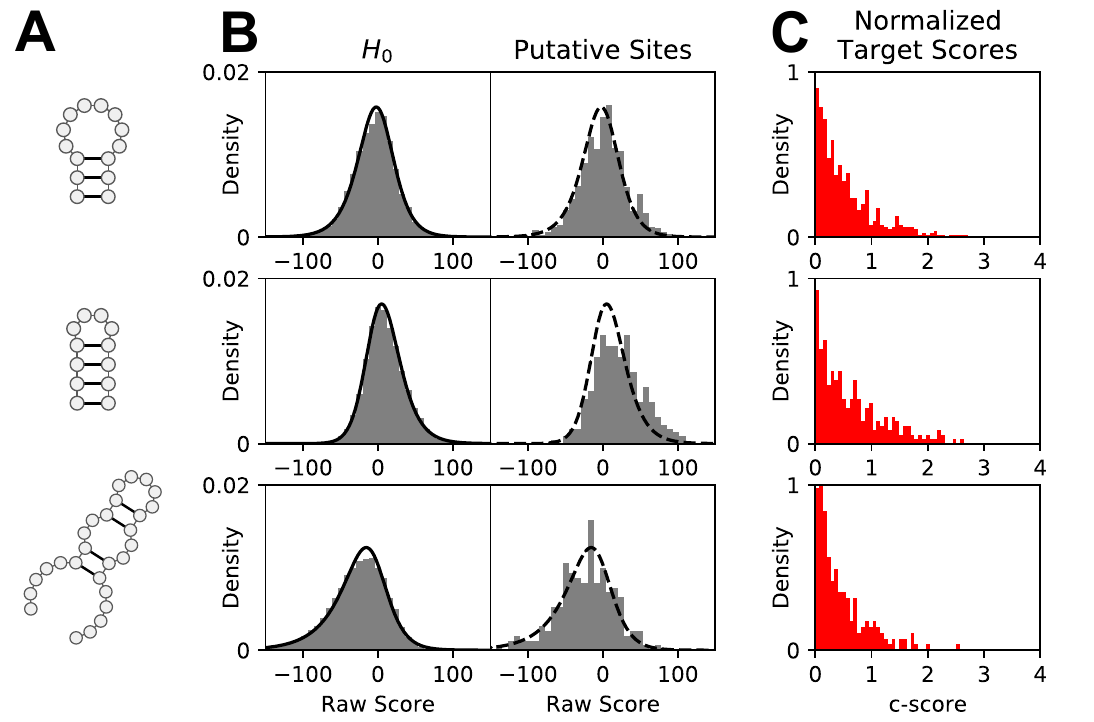
Figure 2. Normalization of patteRNA raw scores to c -scores. ( A ) Secondary structure of the target motifs. ( B ) Raw scores at null sites (H 0 , left) and raw scores at putative sites satisfying sequence constraints (right). Null sites refer to sites where the RNA sequence precludes formation of the target motif. The solid black curves correspond to a skew-logistic density function fitted on the null scores. On the right panels, the same fitted density is superimposed (dashed curve) and is used to normalize target scores. ( C ) Distributions of normalized putative scores, i.e., c